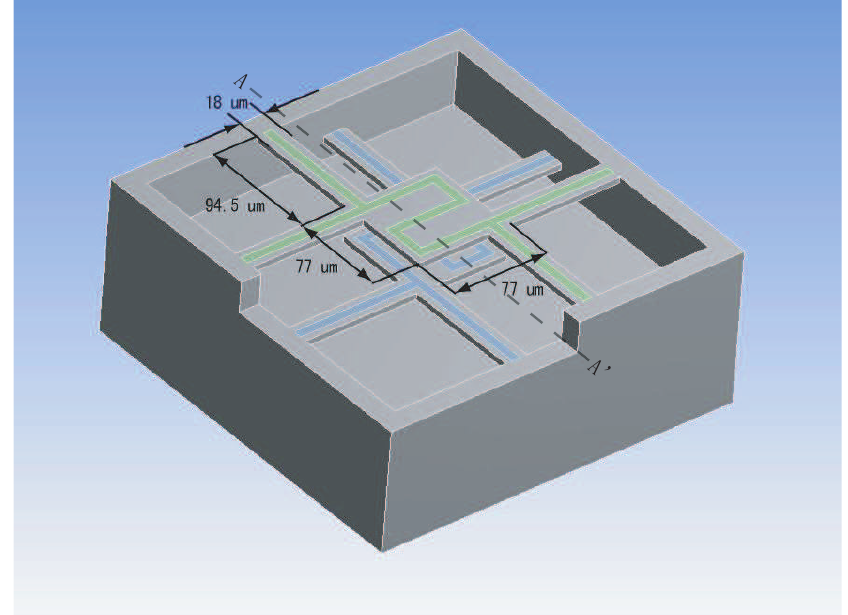
Figure 1. 3D diagram of the sensor.